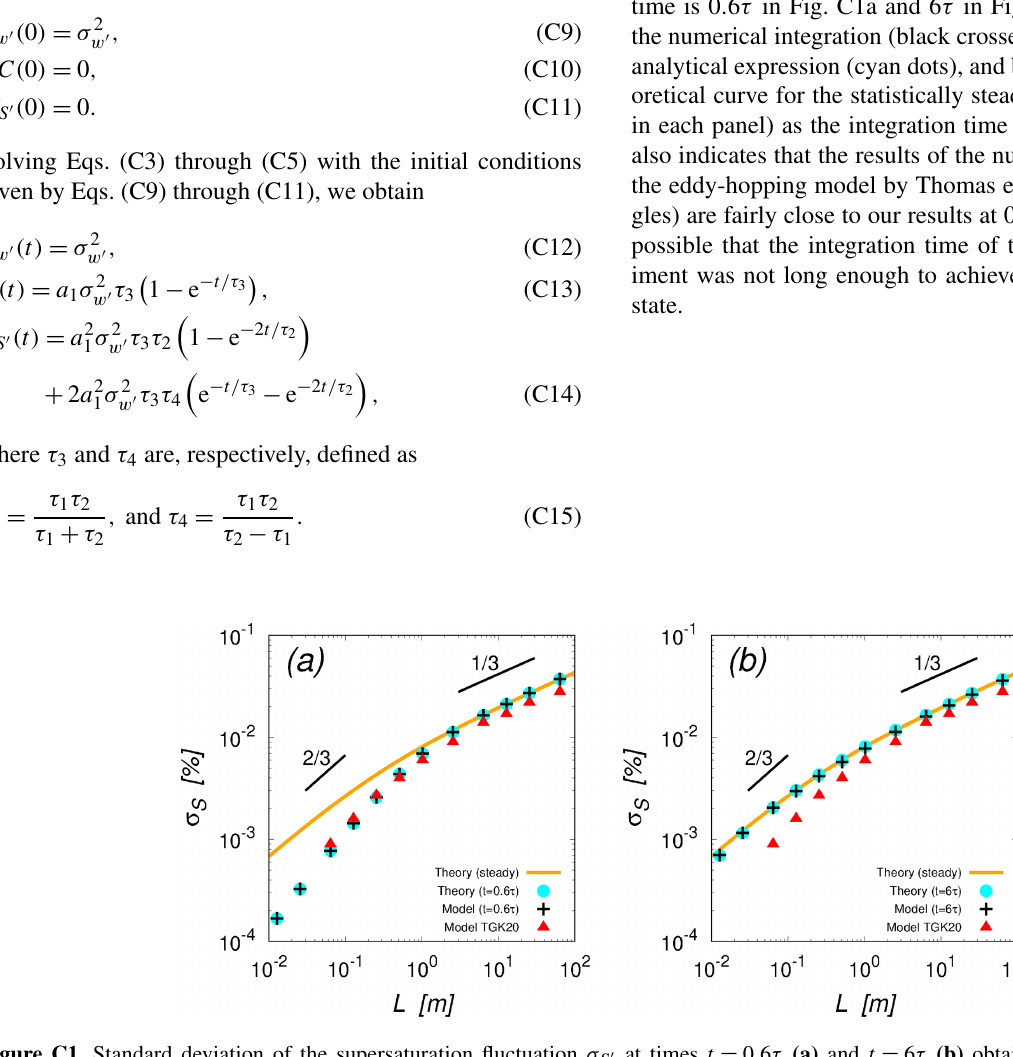
Figure C1. Standard deviation of the supersaturation fluctuation σ S (cid:48) at times t = 0 . 6 τ (a) and t = 6 τ (b) obtained from the analytical expression given by Eq. (C14) (cyan dots) and the results of the numerical integration of the original version given by Eqs. (1) and (2) (black crosses). The orange curve, red triangles, and axes of the panel are the same as in Fig. 1. The two short black lines indicate slopes of 2 / 3 and 1 / 3. The setting for the numerical integration is the same as that used in Sect. 3, except that the integration times are 0 . 6 τ and 6 τ in (a) and (b) ,